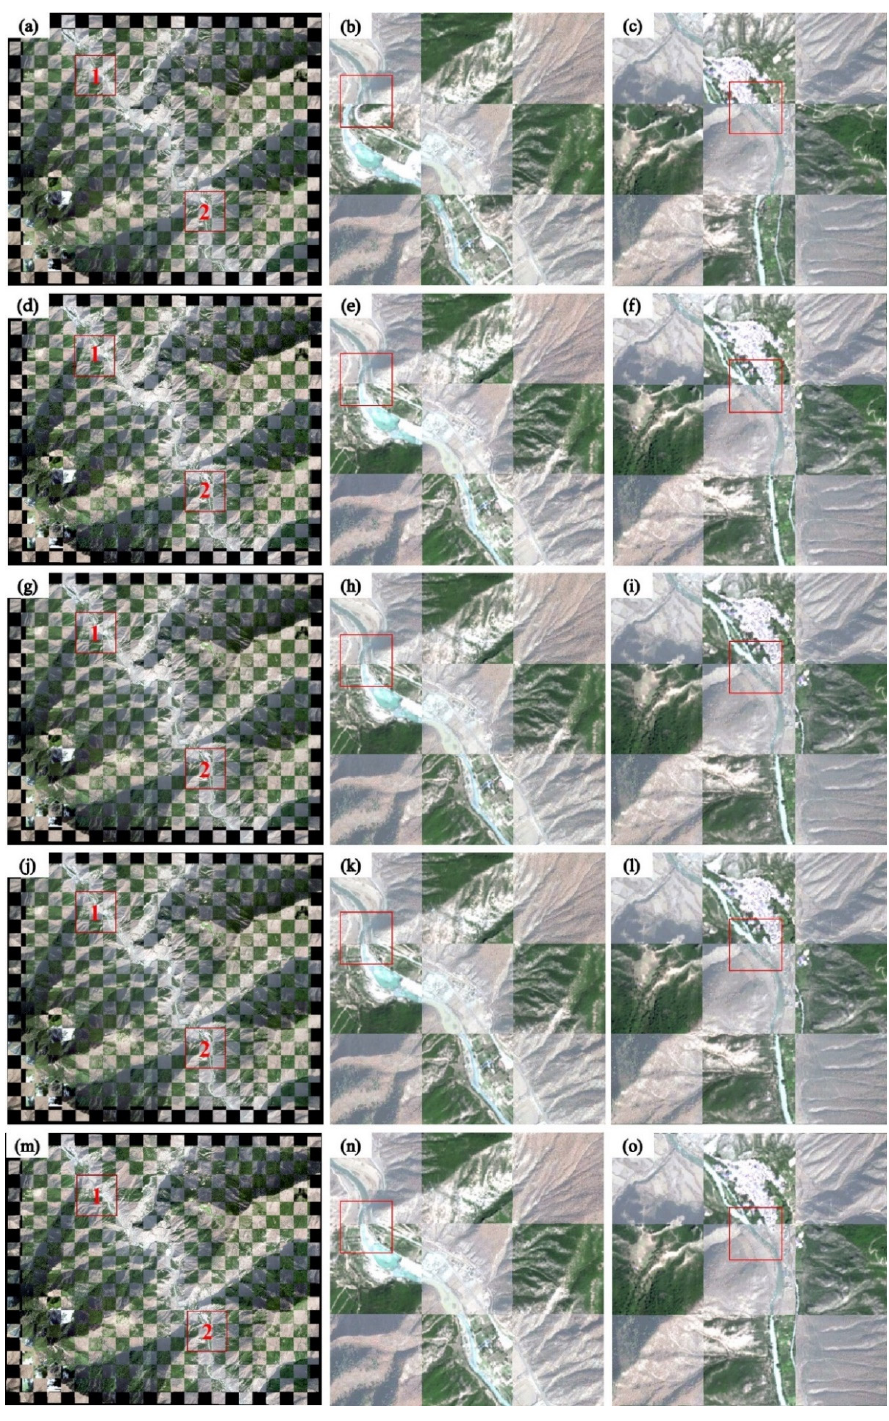
Figure 13. Checkerboard images for the P-E dataset. ( a ) Original image; ( b ) enlarged image of red box 1 in ( a ); ( c ) enlarged image of red box 2 in ( a ); ( d ) result for the proposed method; ( e ) enlarged image of red box 1 in ( d ); ( f ) enlarged image of red box 2 in ( d ); ( g ) result for the Patch-SIFT; ( h ) enlarged image of red box 1 in ( g ); ( i ) enlarged image of red box 2 in ( g ); ( j ) result for the SIFT; ( k ) enlarged image of red box 1 in ( j ); ( l ) enlarged image of red box 2 in ( j ); and ( m ) result for the SURF; ( n ) enlarged image of red box 1 in ( m ); ( o ) enlarged image of red box 2 in ( m ). The red boxes indicate the regions where noticeable differences can be observed.